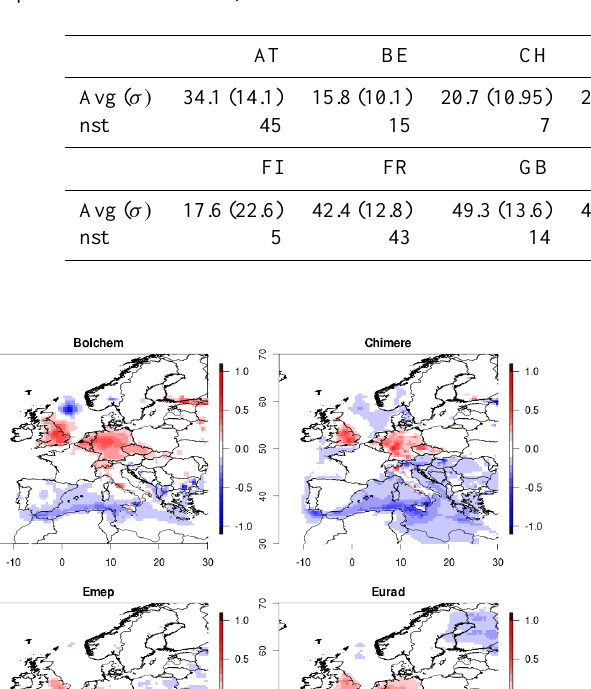
Table 6. Percentage of underestimation in the modelled median interannual variability (average – avg - and standard deviation – σ) at all stations of a given country and across all models. The interannual variability is estimated as the distribution of residuals of the de-seasonalised residuals of the linear fit of monthly time series. Only countries where at least 5 stations are available are shown (number of selected stations – nst – provided on the last row).